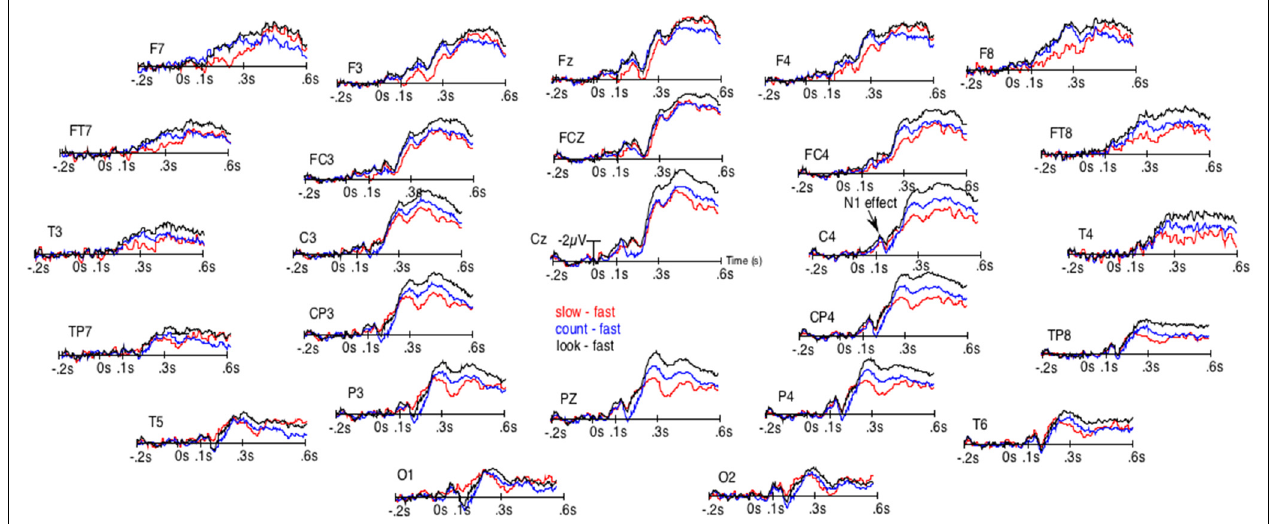
FIGURE 2 | Results of the unsmoothed subtractions of the grand averages of the ERPs elicited by the occurrence of the space bar when RTs were the fastest from the ERPs when RTs were the slowest (red lines), from the ERPs in the count block-task (blue lines) and from the ERPs of the look-only block-task (black lines). These subtractions were performed to distinguish the N1-effect from the effect on late